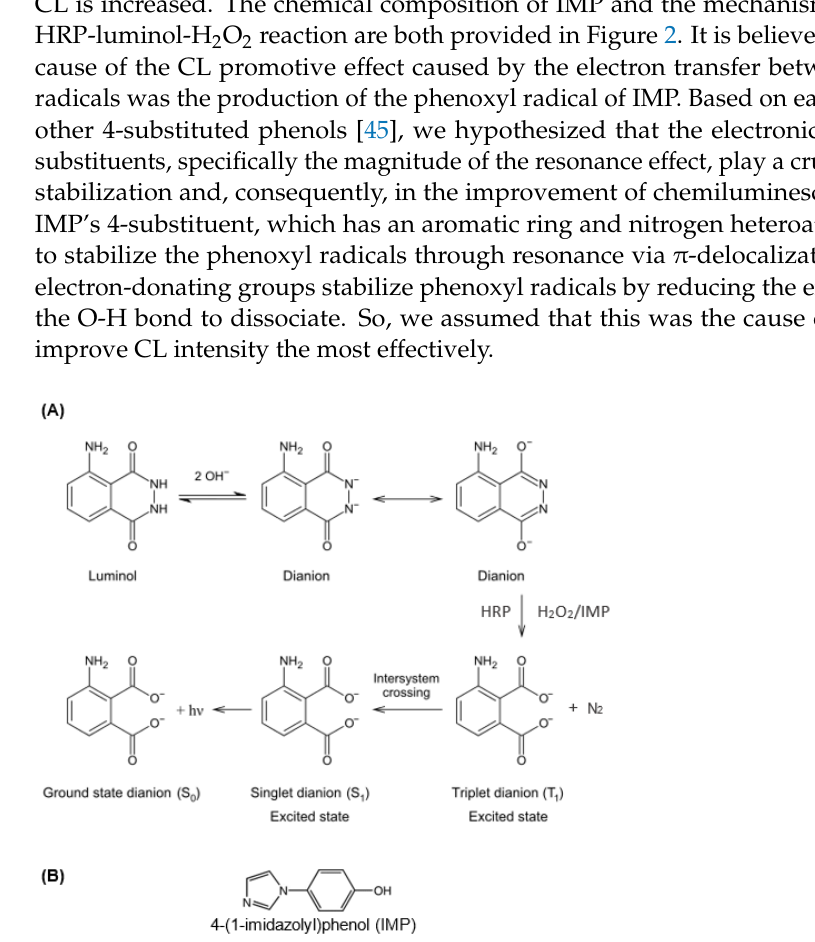
Figure 2. The mechanism of enhanced CL reaction-catalyzed HRP ( A ) and the chemical structure of 4-(1-imidazolyl)phenol (IMP) used as a CL enhancer for HRP-luminol-H 2 O 2 reaction ( B